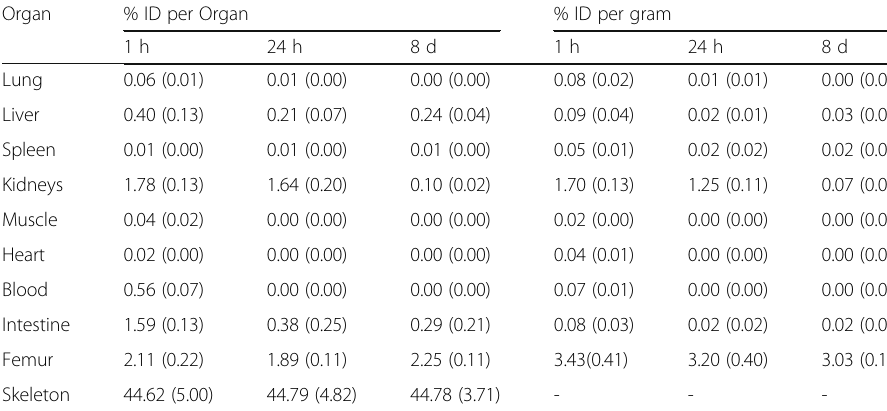
Each value represents the mean (S.D.) for four animals